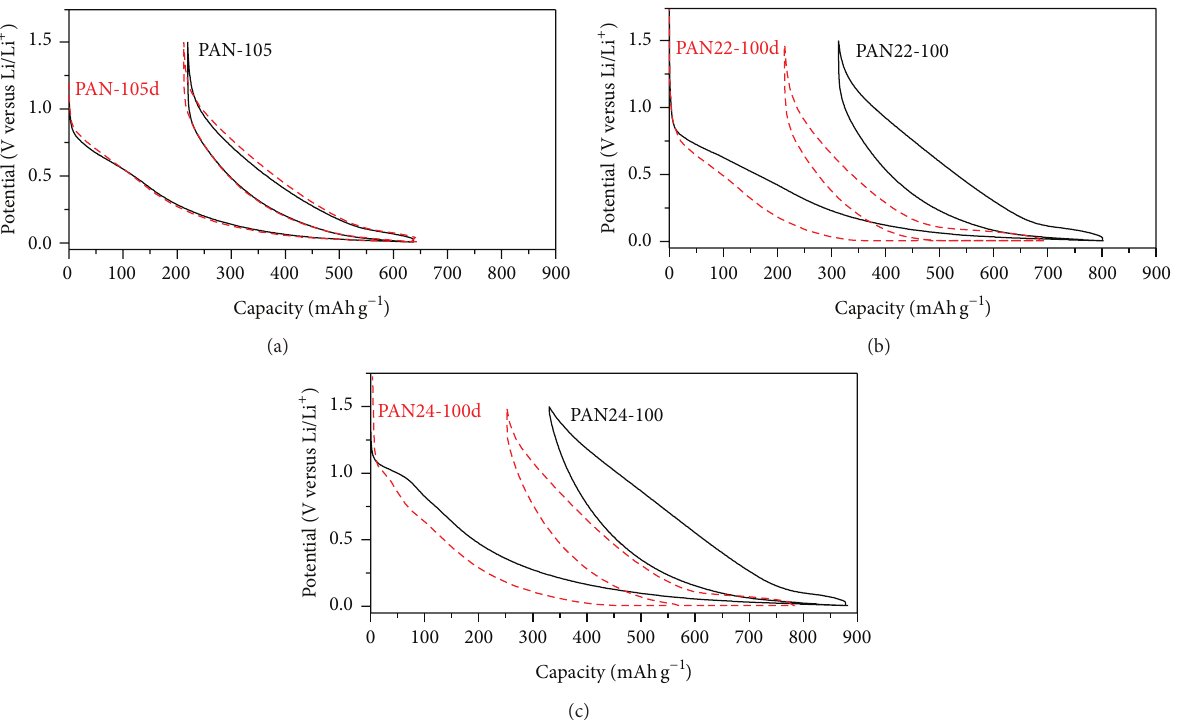
Figure 11: Effect of pyrolytic carbon coating on the galvanostatic lithium insertion/deinsertion in PAN-105 (a), PAN22-100 (b), and PAN24- 100 (c).